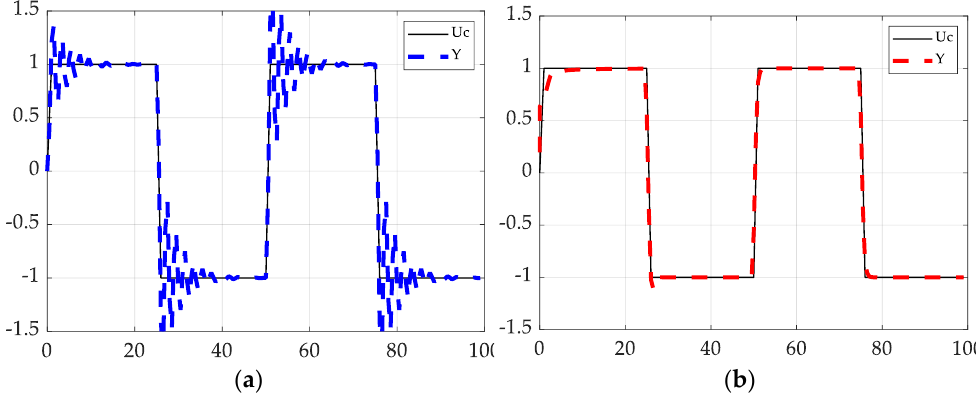
Figure 6. The output signals at a step-size of 0.50 s. ( a ) The black solid line describes the command signal. The blue dotted line (Left) represents the output signal generated by discrete D.A.I.; ( b ) the red dotted line (Right) describes the output signal generated by model-following method coupled with R.L.S. estimation.